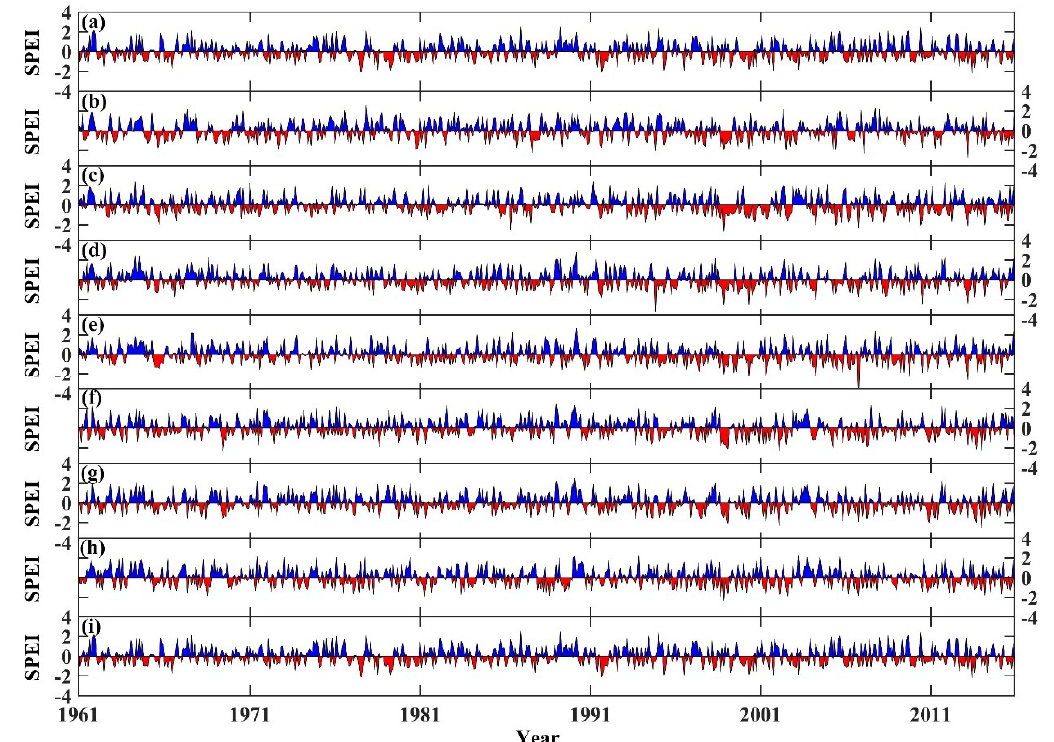
Figure 2. Temporal evolution characteristics of drought in the YRB. ( a – i ) denote above Longyangxia (AL), Longyangxia to Lanzhou (LL), Lanzhou to Hekou (LH), Inner Flow region (IF), Hekou to Longmen (HL), Longmen to Sanmenxia (LS), Sanmenxia to Huayuankou (SH), below Huayuankou (BH), and Yellow River basin.